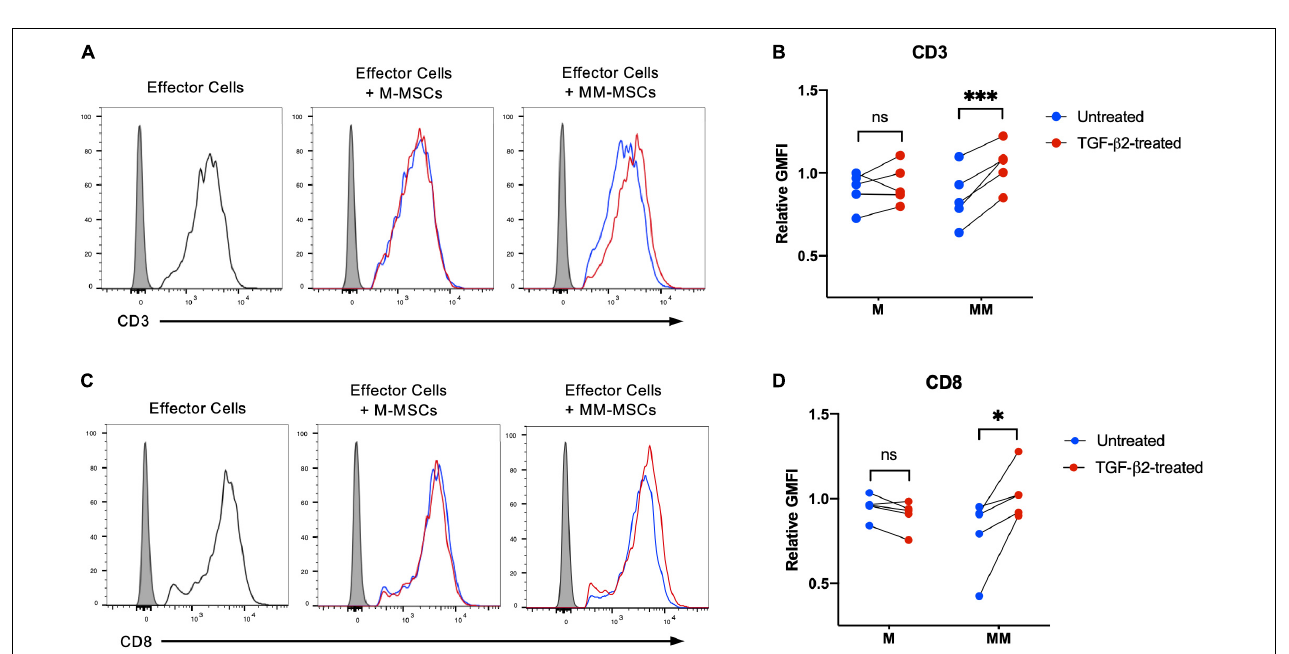
FIGURE 2 | PGE2 and TGF- β 1 are secreted in MLRs with PBL and MSC stimulator cells. (A) PGE2 concentrations in the supernatant of MLRs as measured by ELISA. Data shown are mean ± SD of n = 6, p < 0.0001 by ANCOVA. Superscript letters indicate significant difference between groups. (B) TGF- β 1 concentrations in MLR supernatant as measured by ELISA. Data shown are mean, minimum, and maximum values for n = 6, non-significant by ANCOVA.